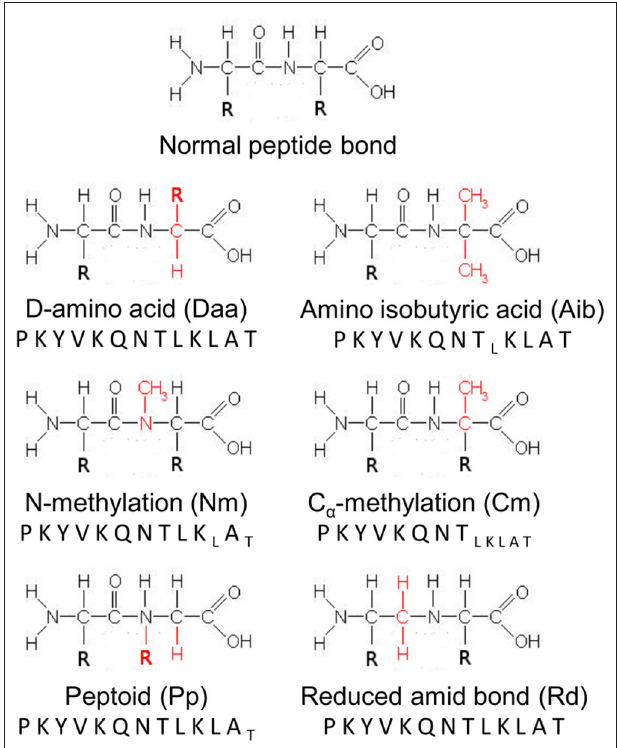
FIGURE 1 | Schematic representation of modifications introduced into the HA peptide. A normal peptide bond is represented as reference. R refers to the side-chains of the amino acids involved in the peptide bond, while chemical groups colored red designate the chemical modifications introduced at each position of the HA peptide sequence. Letters in subscript refer to analogs, which could not be synthesized by the manufacturer and tested.